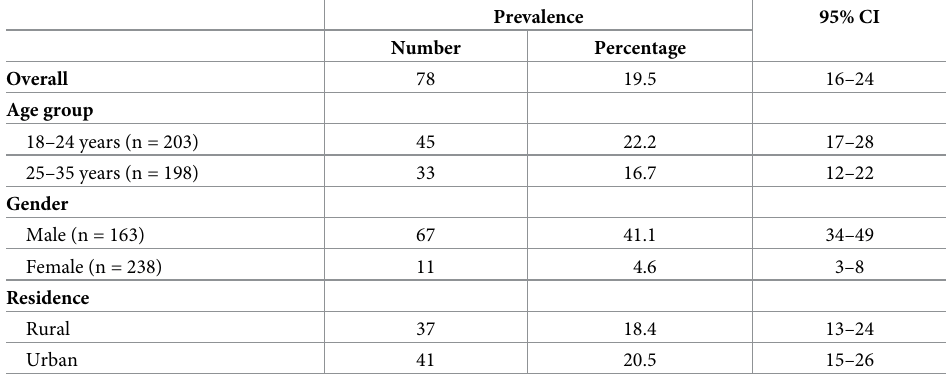
Table 1. Prevalence of tattooing among participants, Mandalay Region, 2015 (n =